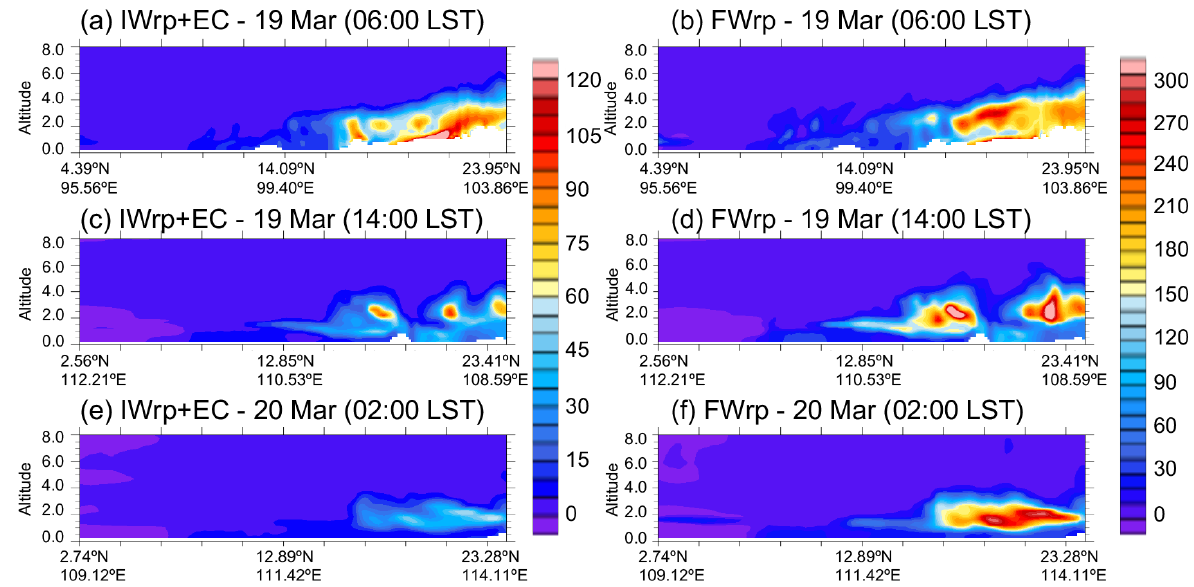
Figure 6. Comparison of model PM 10 (µgm − 3 ) cross-sectional profile corresponding to CALIPSO period and swath in Fig. 4. The range of the left panel is 0–120µgm − 3 , and the range of the right panel is 0–300µgm − 3